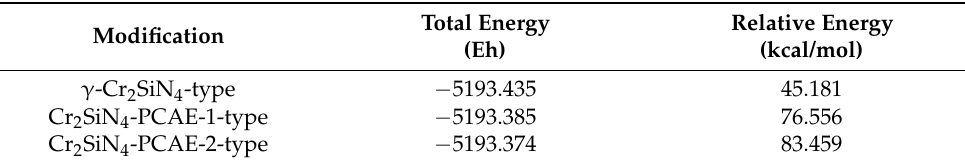
Table 6. The total energy and relative energy values compared to the global minimum (spinel structure taken as the zero of the energy) of Cr 2 SiN 4 modifications found using the PCAE method and locally optimized using the GGA-PBE